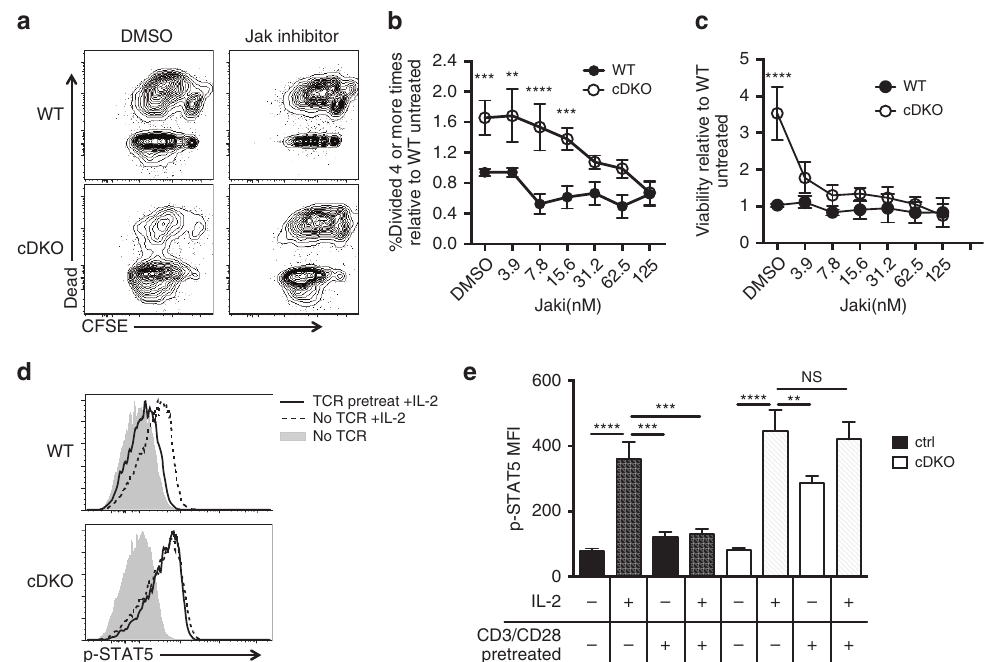
Figure 8 | Ndfip-deficient Tcells show persistent cytokine signalling. ( a – c ) Sorted naive CD4 þ Tcells from WTand cDKO mice were stimulated with a CD3/CD28 in the presence of Jak inhibitor I (JAKi) and analysed on day 5 by flow cytometry. ( a ) Representative plots of CFSE dilution and viability staining in WT and cDKO CD4 þ T cells ± Jak inhibitor (31.2nM). ( b , c ) Quantification of ( b ) percent of cDKO and WT cells divided four or more times relative to DMSO-treated experiment-matched WT cells and ( c ) viability of cDKO and WT CD4 þ T cells normalized to DMSO-treated experiment- matched WT cells. Data shown is average ± s.e.m. from six biologic replicates. P values calculated by multiple t -test with Holm–Sidak correction. ( d , e ) p-STAT5 staining in cDKO and WT CD4 þ T cells rested in the absence of IL-2 overnight then treated ± a CD3/CD28 beads before addition of IL-2. ( d ) Representative flow cytometry histograms. ( e ) Quantification of p-STAT5 MFI for eight to nine biologic replicates and four independent experiments, showing average ± s.e.m. Patterned bars indicate addition of exogenous IL-2. P values calculated by two-way ANOVA with Holm–Sidak test for